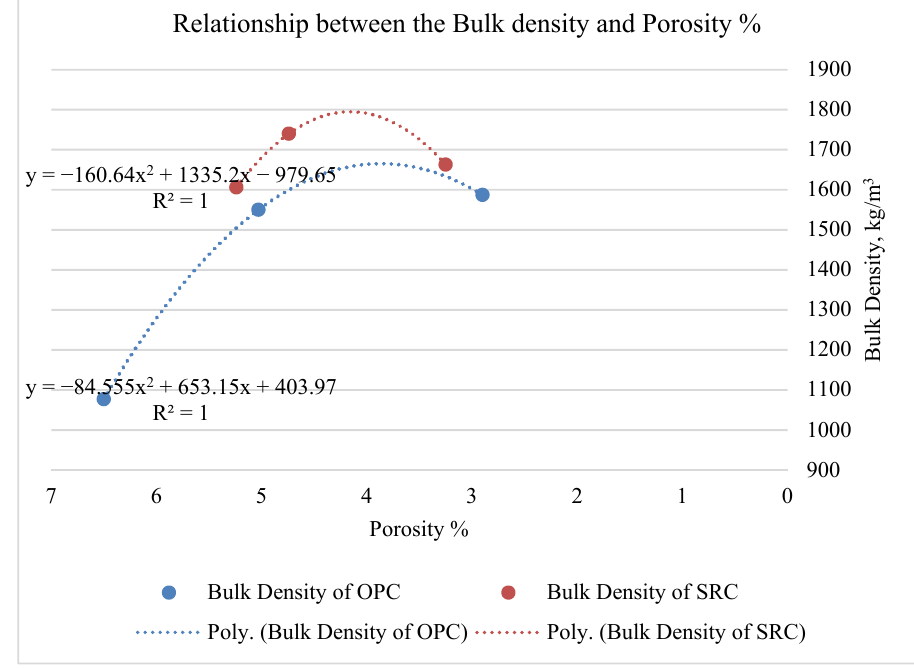
y = −84.555x 2 + 653.15x + 403.97